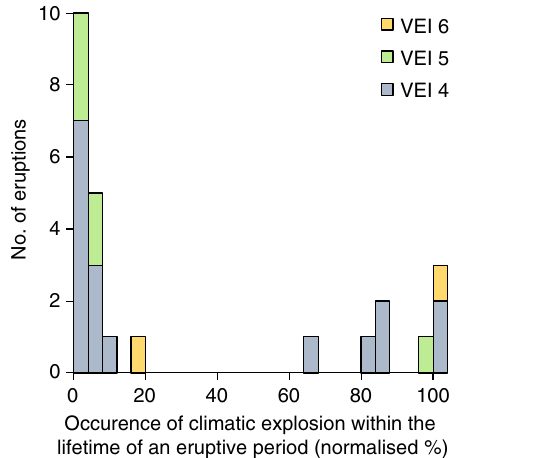
Occurence of climatic explosion within the lifetime of an eruptive period (normalised %) Fig. 2 Graph of known eruptive time periods with both climactic explosions (VEI ≥ 4) and dome growth (including crypto-domes) from the Domehaz database 22 . All eruptive time periods (which includes smaller explosions, dome extrusion) have been normalized. Two-thirds of the climactic eruptions occur at the start of their eruptive period ( fi rst quarter), irrespective of VEI. However, ~1/3 of climactic eruptions occur in the latter half of an eruptive cycle